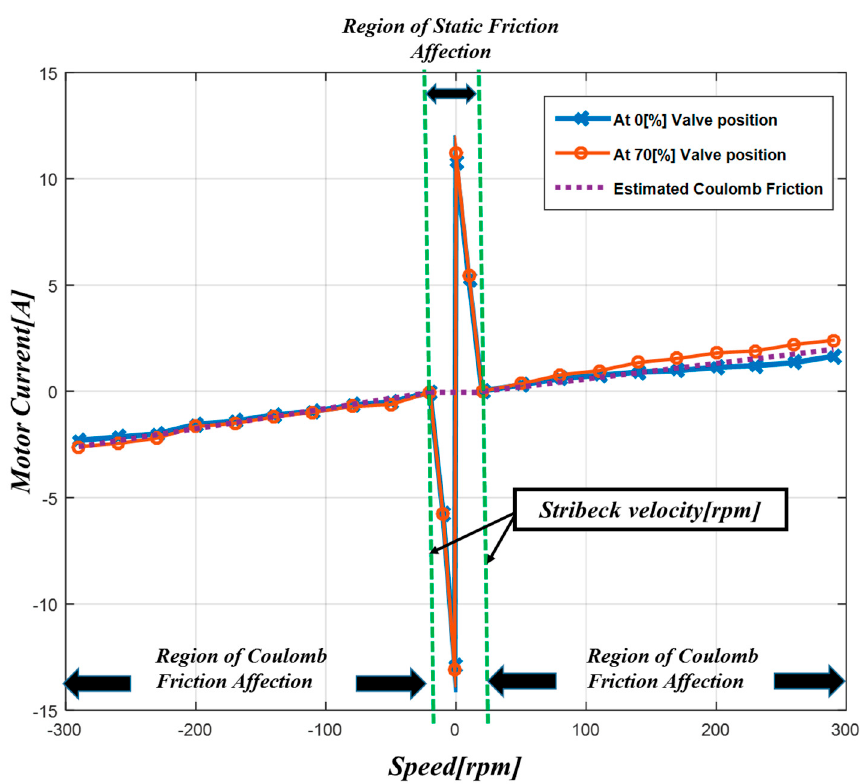
Figure 3. Measured friction torque.